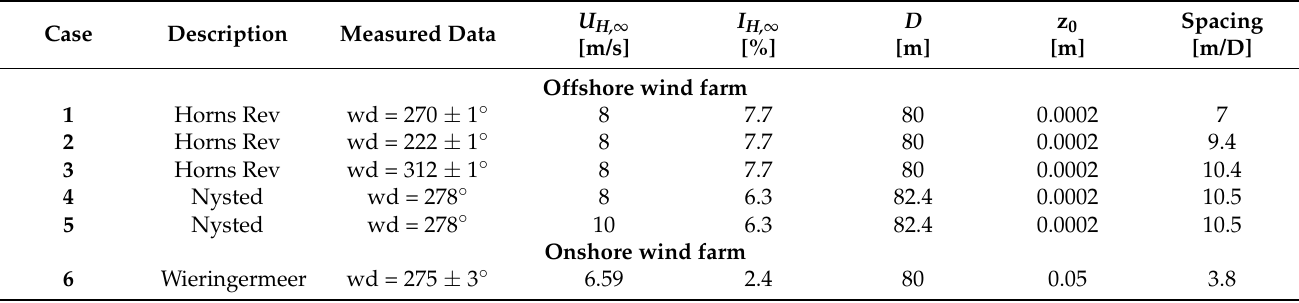
Table 4. Test cases and corresponding input operating